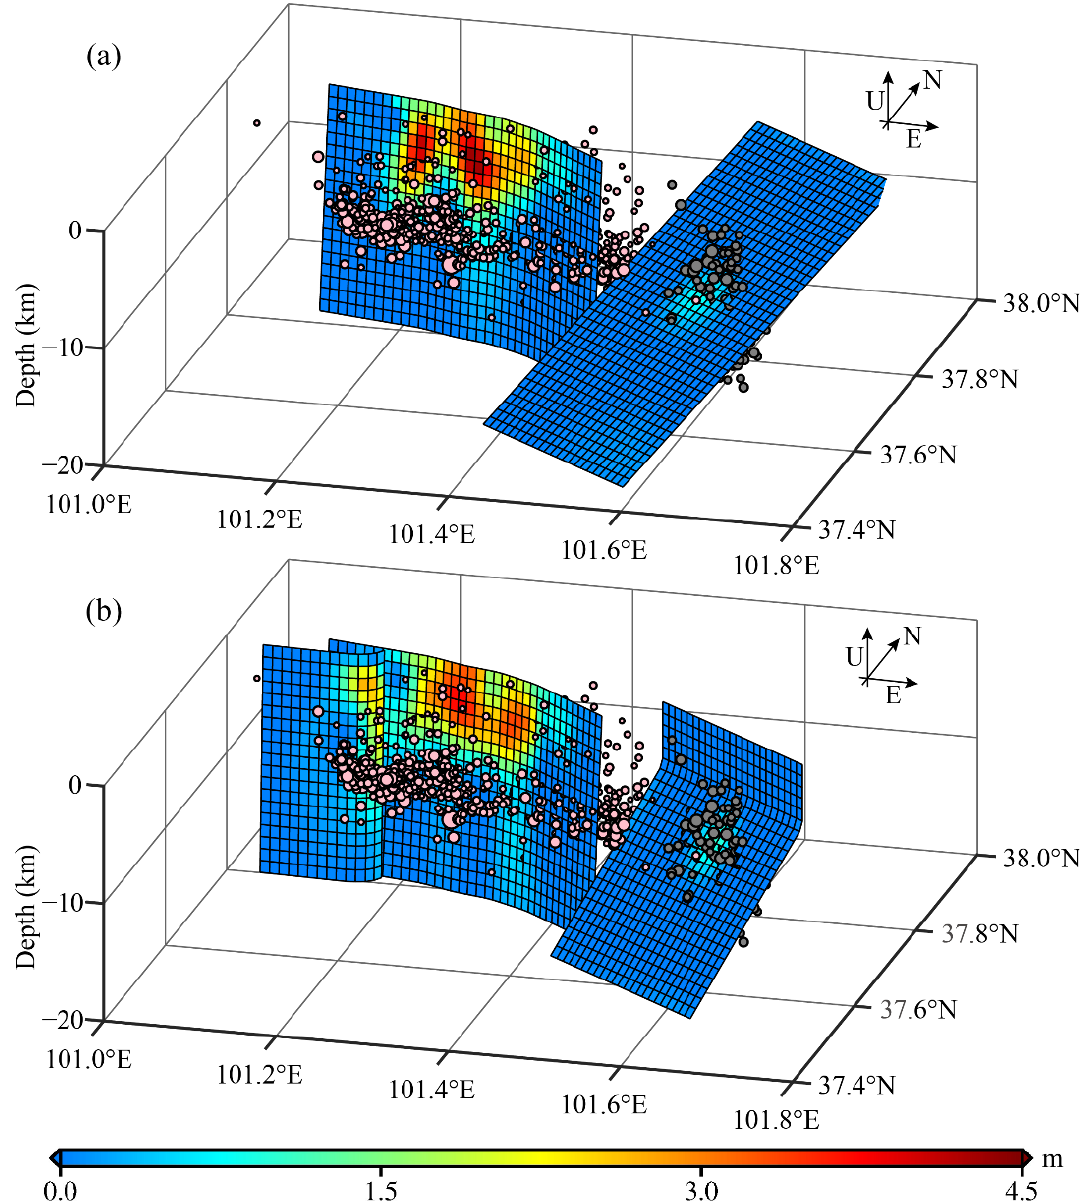
Figure 7. Three-dimensional view of the slip distribution collage obtained from different fault models of the 2016 and 2022 Menyuan earthquakes. ( a ) The MYDMYF model for the 2016 earthquake and the single main fault model for the 2022 event. ( b ) The NLLLF model for the 2016 event and the two-fault model for the 2022 earthquake. The pink and gray circles are the relocated aftershocks of the 2022 and 2016 earthquakes [18,28].